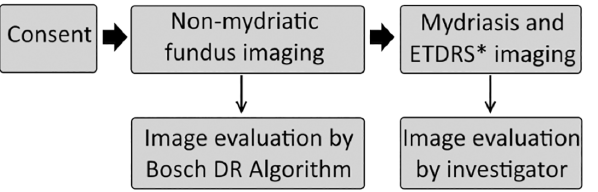
Fig 1. Processflow of subjects. * ETDRS: ETDRS seven-standard-field 35-mm stereoscopic color retinal